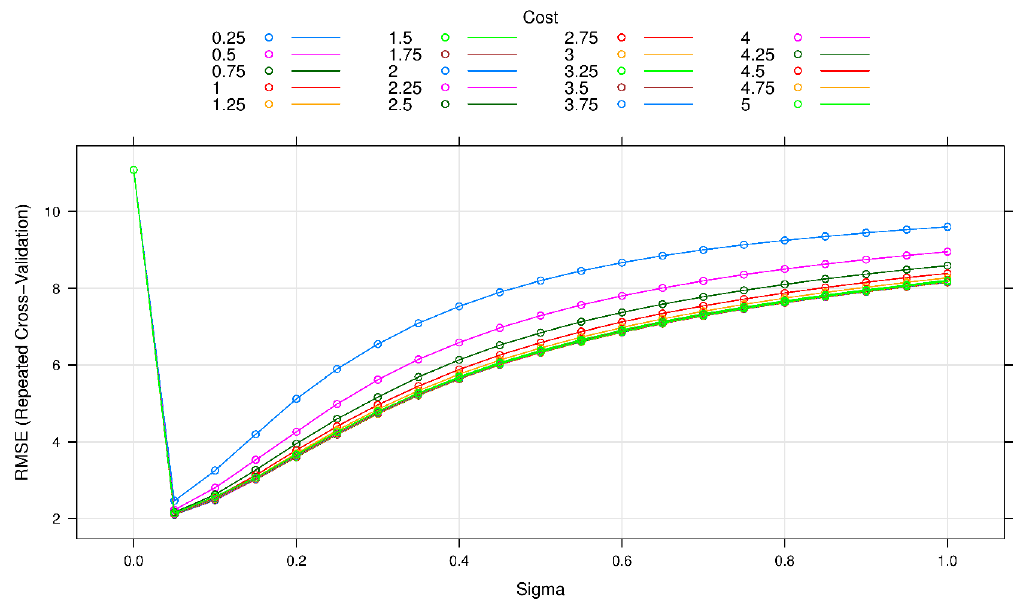
Figure 7. The development process of the SVM model for estimating HL